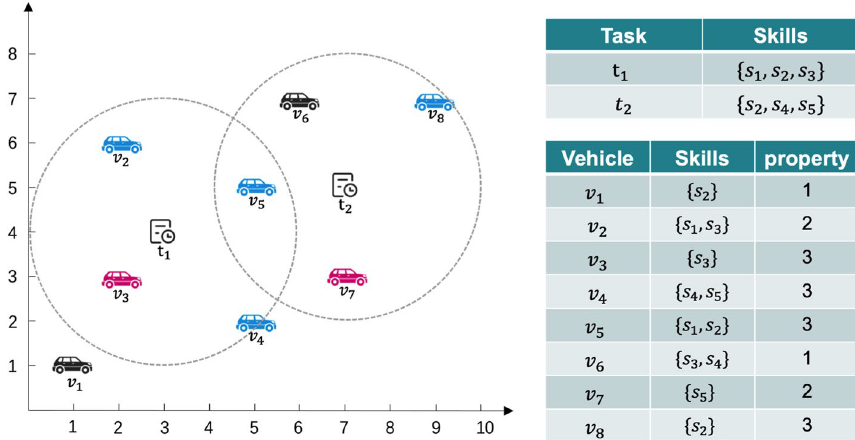
Fig. 1 Information of unmanned vehicles/tasks